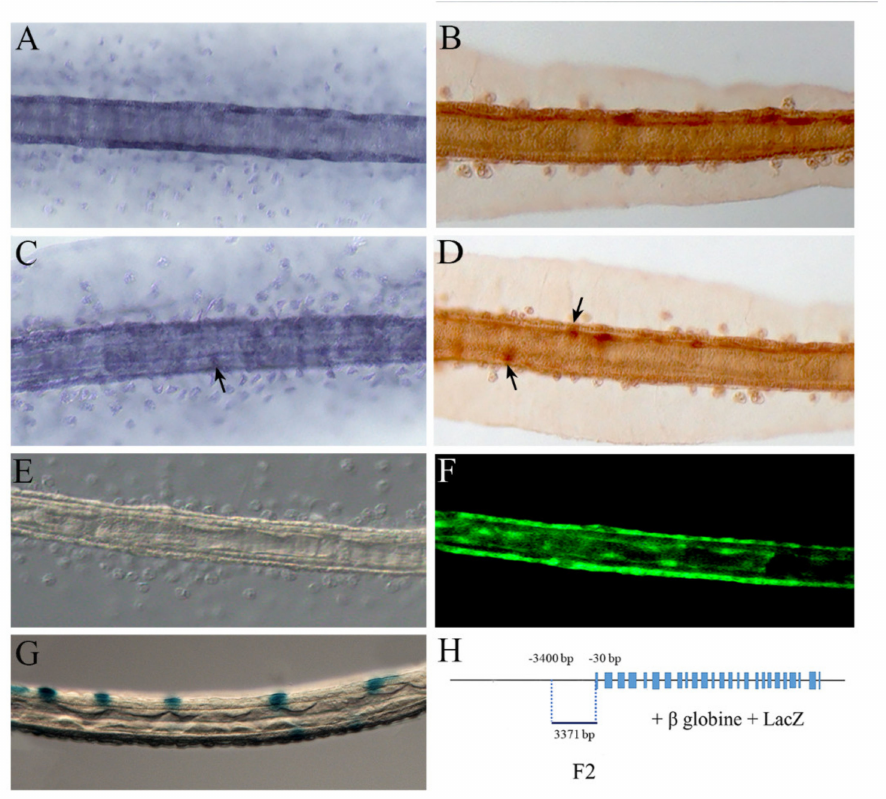
Figure 3. NOS and NO localization in the Ciona larval tail. ( A ) Nos gene expression in the epidermal cells of the tail at the larval stage by in situ hybridization. ( B ) Immunochemistry assay of NOS, using antibody uNOS, at the late larval stage. ( C , D ) NOS gene and protein expression in tail epidermal neurons (arrows) in the larval stage by in situ hybridization and immunochemistry assay, respectively. ( E , F ) NO localization by DAF-FM-DA in the epidermis and tail epidermal neurons of a late larval tail. Bright field ( E ) and dark field ( F ) of the same larva. ( G ) Transgenic assay of Ciona F2 Nos regulatory region. ( H ) Schematic representation of F2 sequence position along the Nos gene